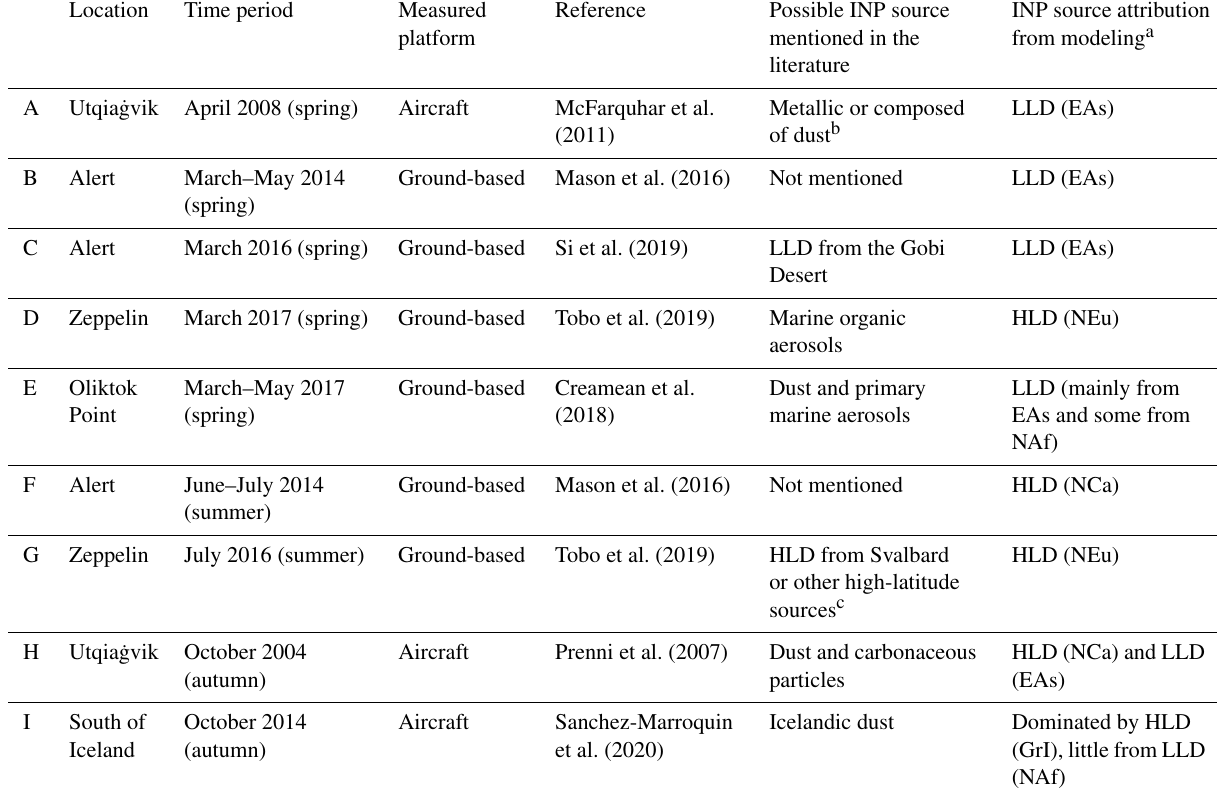
Table 3. Summary of the nine Arctic INP measurements used for INP comparisons in Fig.